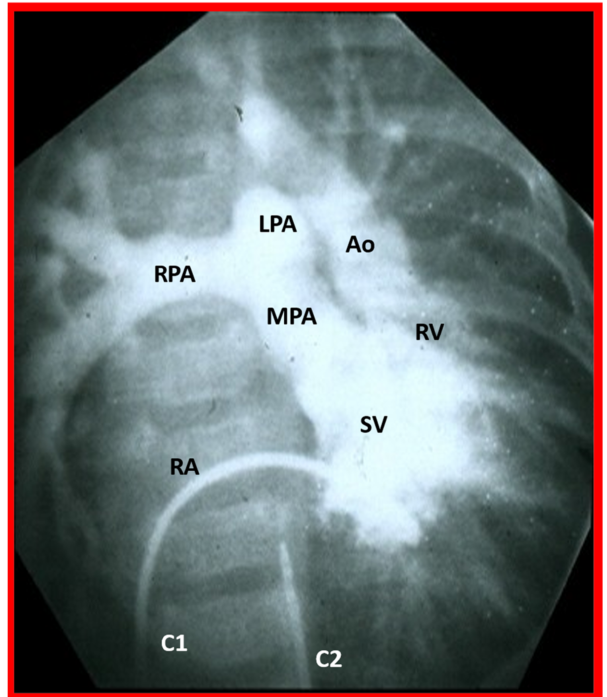
Figure 6. Selected cine frame in the postero-anterior projection of a single ventricular (SV) cine- angiogram demonstrating simultaneous opacification of the main (MPA), left (LPA), and right (RPA) pulmonary arteries from the SV and the aorta (Ao) from the right ventricle (RV). Note that the Ao is positioned to the left of the MPA, indicating l-transposition of the great vessels. C1. Catheter in the inferior vena cava (not marked) which was advanced into the right atrium (RA) and then into the SV; C2. Catheter in the descending aorta (not